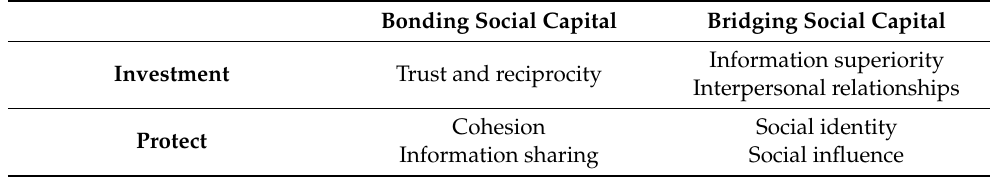
Table 6. Project resilience measurement